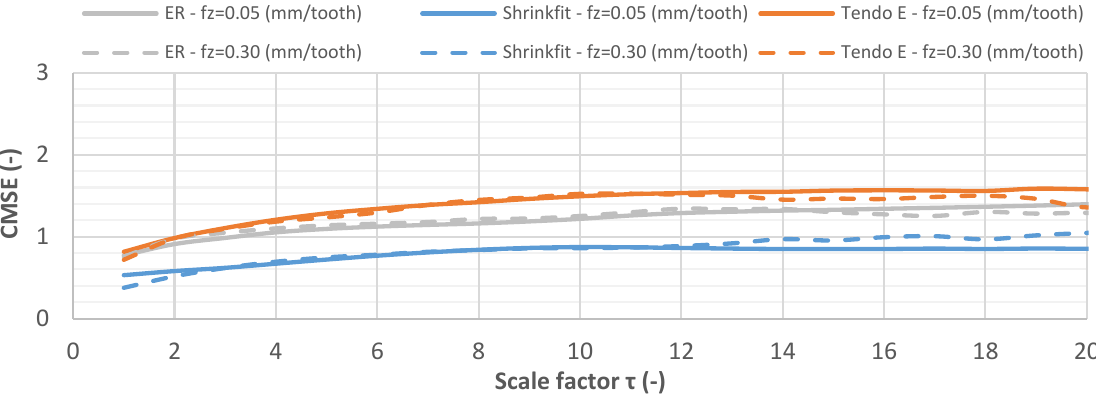
Figure 19. CMSE for vibration displacement signals while milling at f z = 0.05 mm/tooth and f z = 0.30 mm/tooth (v c = 800 m/min, a p = 6 mm).